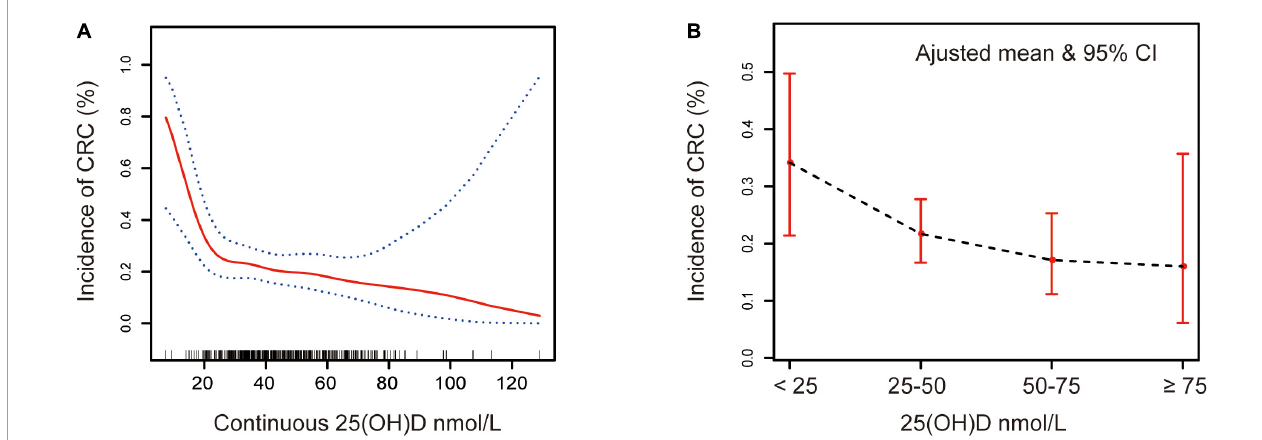
FIGURE1 Association between serum 25(OH)D and CRC. Adjusted for sex, age, polyp history, diabetes, hypertension, smoking, alcohol, aspirin, statins, ACEI, VB1, VB2, VB6, VB9, VB12, VC, VE, VA, and BMI. (A) Red solid line represents the spline plots of continuous 25(OH)D concentration, and the blue dotted line represent the 95% confidence intervals of the spline plots. (B) The bar plot of four-level serum 25(OH)D groups with adjusted mean and 95% CIs. Vitamin D deficiency: 25(OH)D < 25 nmol/L, vitamin D insufficiency: 25(OH)D 25–50 nmol/L, vitamin D adequate: 25(OH)D 50–75 nmol/L, and vitamin D sufficiency: 25(OH)D ≥ 75 nmol/L.